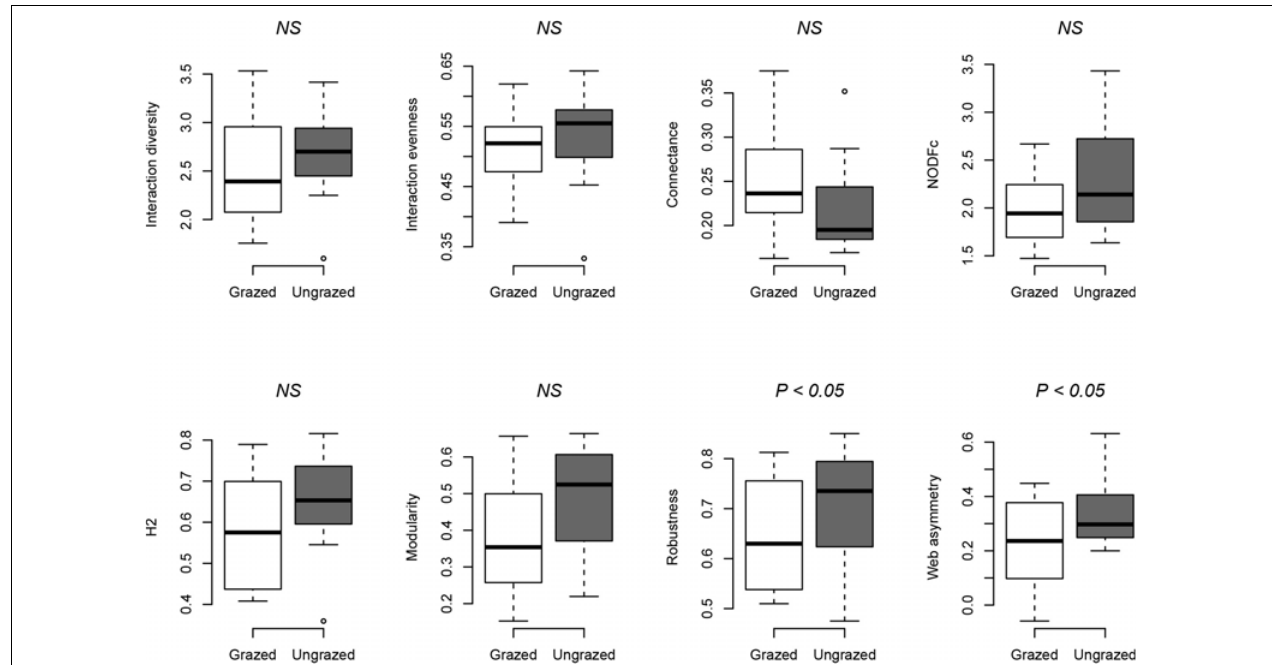
FIGURE 2 | Box plots illustrating the network structure metrics in grazed and ungrazed networks ( n = 24 networks). The horizontal lines across boxes are medians. The bottom and top limits of each box are the lower and upper quartiles (25 and 75%, respectively). White boxes represent grazed habitats, and gray boxes represent ungrazed habitats. Statistics are shown in Table 1 . P -values are shown above the box plots; NS indicates no significant difference.